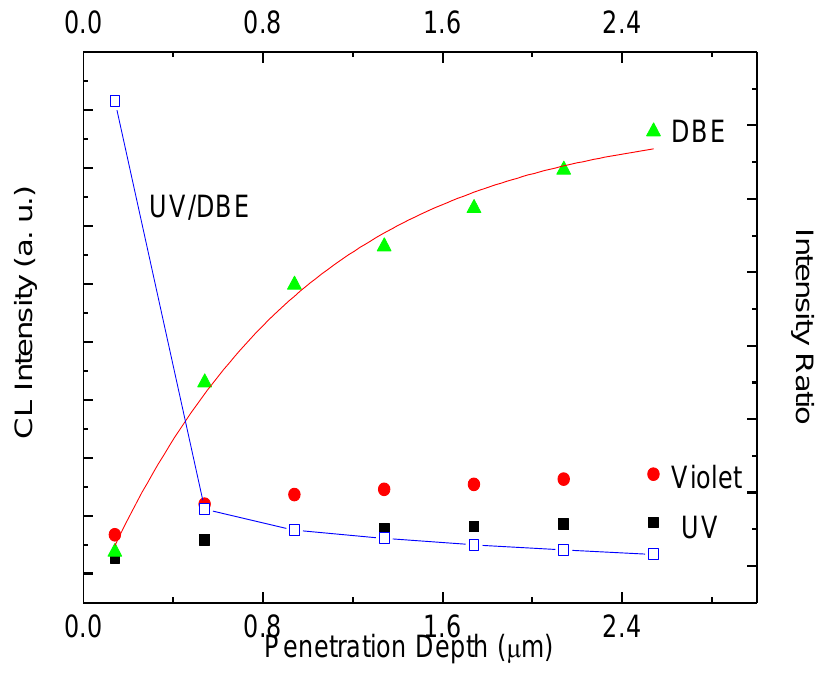
Figure 6. The emission intensity (right axis) of the UV, violet and DBE as well as the ratio of UV and DBE (left axis) as a function of penetration